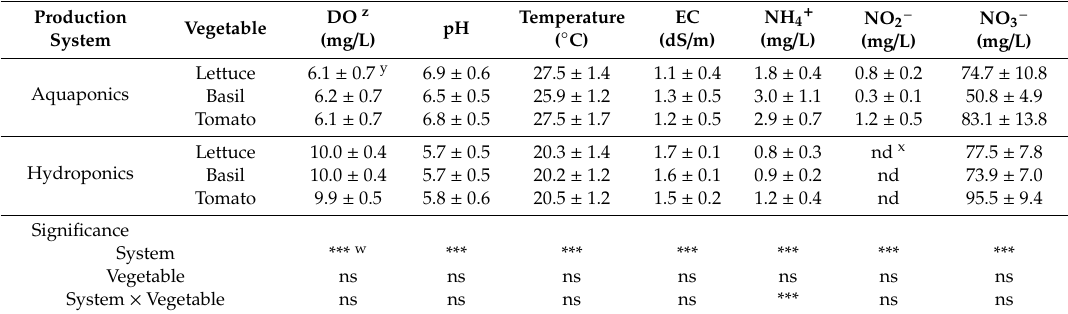
Table 2. Water quality parameters in lettuce-, basil-, and tomato-based aquaponic and hydroponic systems during the experimental